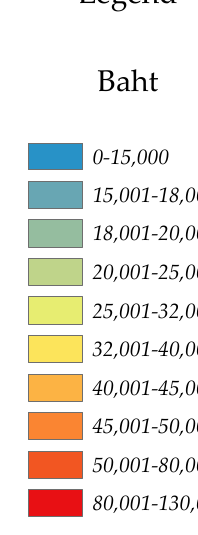
Table 1. Independent variables.